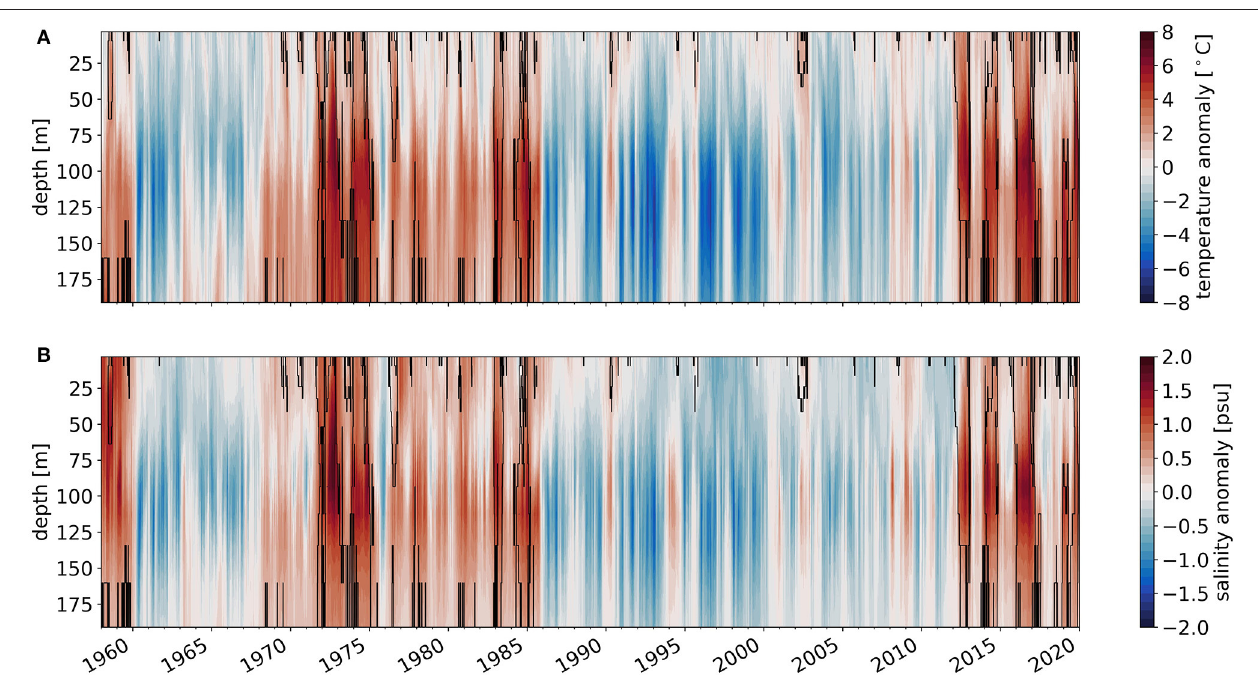
FIGURE 6 | MHW Detection with depth; spatial mean temperature (A) and salinity anomalies (B) over depth and time for the shelf region (ecoboxes, see Figure 1 ); black contour lines indicate MHW